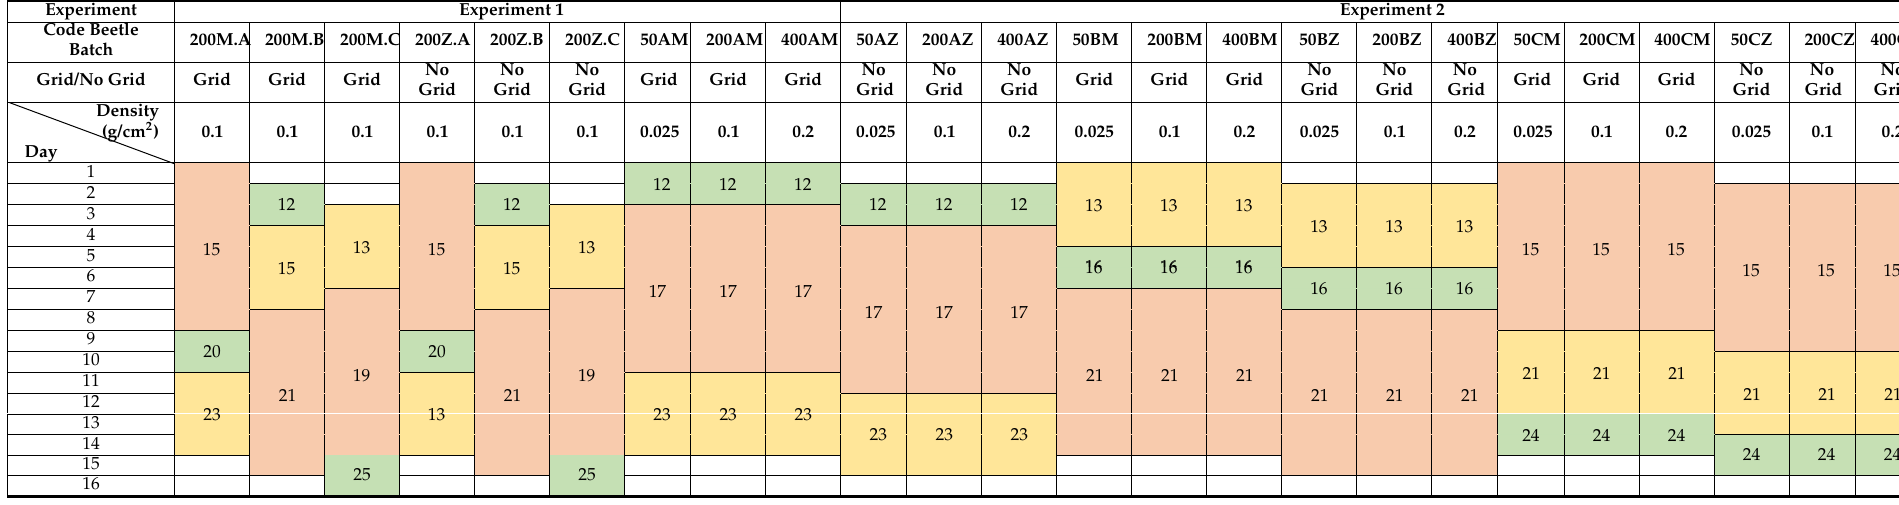
Table 1. Experimental design. Two experiments were performed. Experiment 1: 6 batches of beetles were set up with a density of 0.1 g beetles/cm 2 of which 3 batches with an oviposition grid and 3 batches without an oviposition grid. Experiment 2: beetles were placed in crates at three densities, i.e., 0.025 g (equal to 0.197 beetles/cm 2 ), 0.1 g beetles/cm 2 (equal to 0.788 beetles/cm 2 ) and 0.2 g beetles/cm 2 (equal to 1.576 beetles/cm 2 ). For each density, 6 beetle batches were set up: 3 batches with an oviposition grid and 3 batches without an oviposition grid. For both experiments, each beetle batch was allowed to lay eggs for 2, 4, and 8 days (oviposition duration is indicated in red, green and yellow, respectively). After each oviposition period (2, 4 or 8 days), beetles were removed from the crates and transferred to a new crate with a different oviposition duration. The order of the oviposition duration differed between the batches, allowing the effect of age (mean beetle age during each treatment is indicated in the treatment boxes) to be included in the